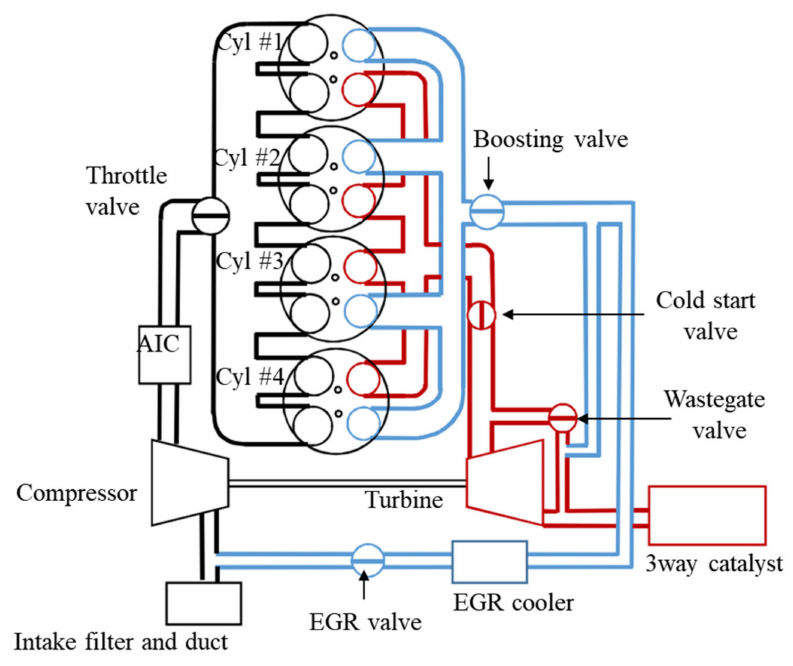
Figure 2. Schematics of developed DEP